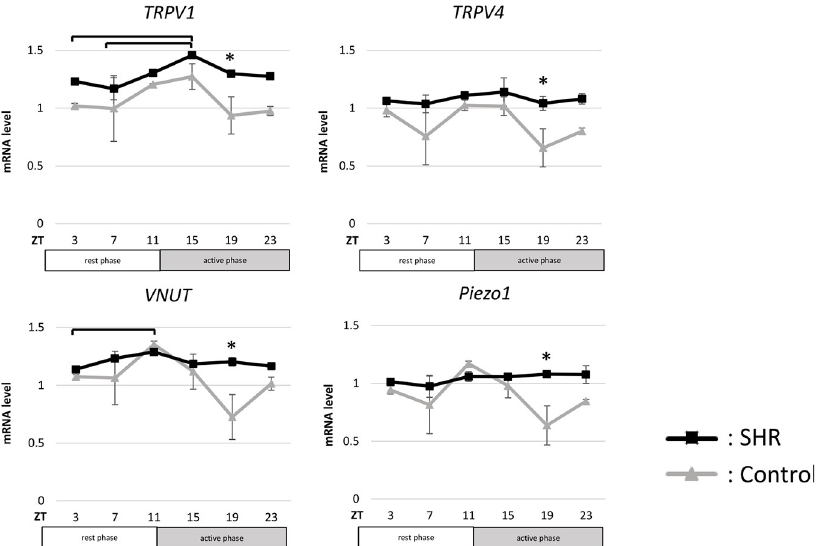
Fig 3. Changes in TRPV1, TRPV4, VNUT and Piezo1 mRNA expression in bladders from Wistar rats (control) and spontaneously hypertensive rats (SHR) bladder. TRPV1 , TRPV4 , VNUT , and Piezo1 mRNA expression rhythms in the bladder in control and SHR under 12-h light/12-h dark cycle. n = 6 for control, n = 6 for SHR at each time point. Statistic analyses were performed using a one-way analysis of variance. � p < 0.05, �� p < 0.01. ZT: zeitgeber time; TRPV1 : transient receptor potential vanilloid channel 1; TRPV4 : transient receptor potential vanilloid channel 4; VNUT : vesicular nucleotide transporter.